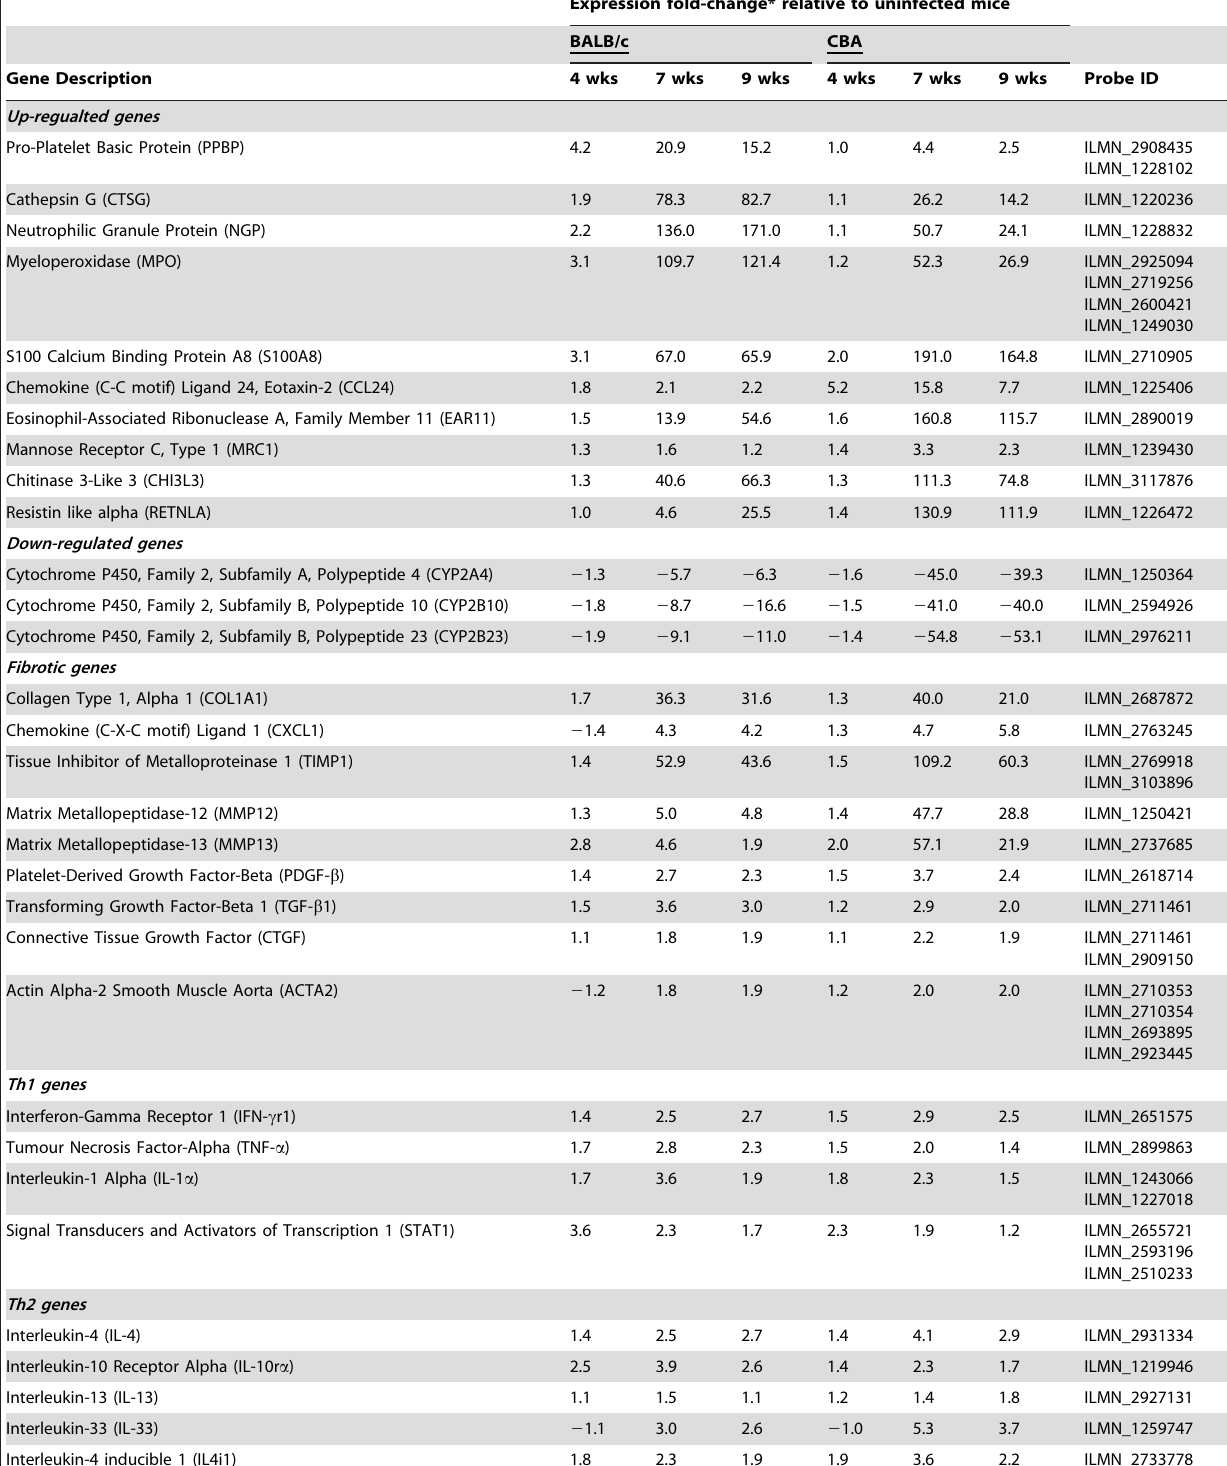
Table 1. Microarray expression patterns for genes of interest in BALB/c and CBA